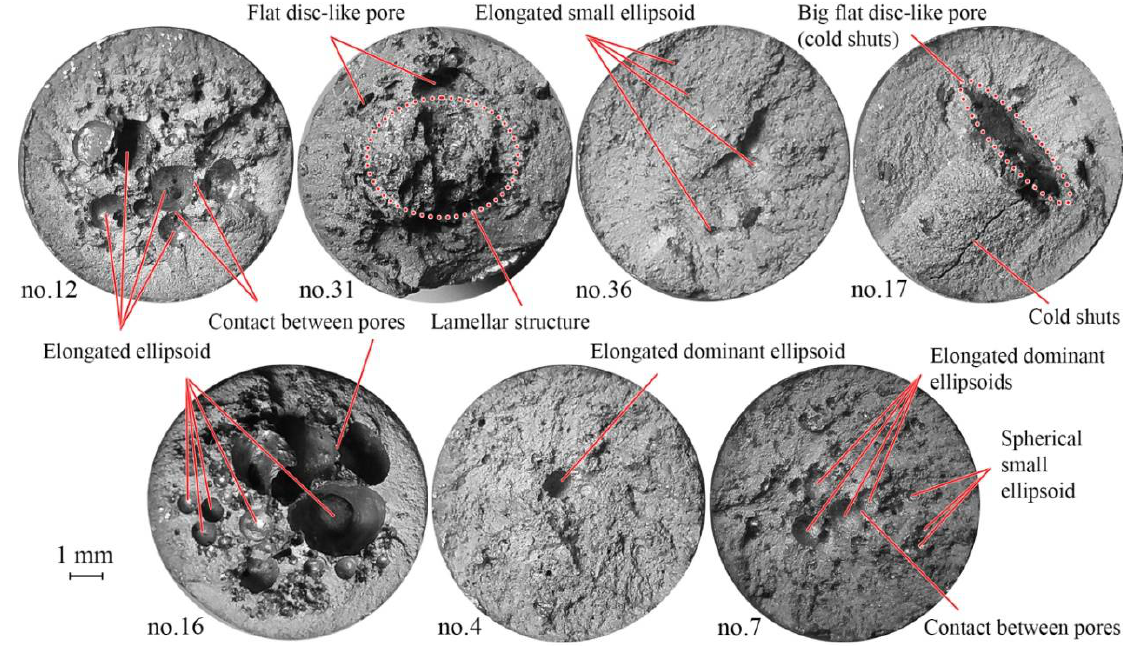
Figure 4. Pores and other inhomogeneities in critical cross-sections; pictures were made using a macro-lens and show fatigue–crack surfaces immediately after the experiment.